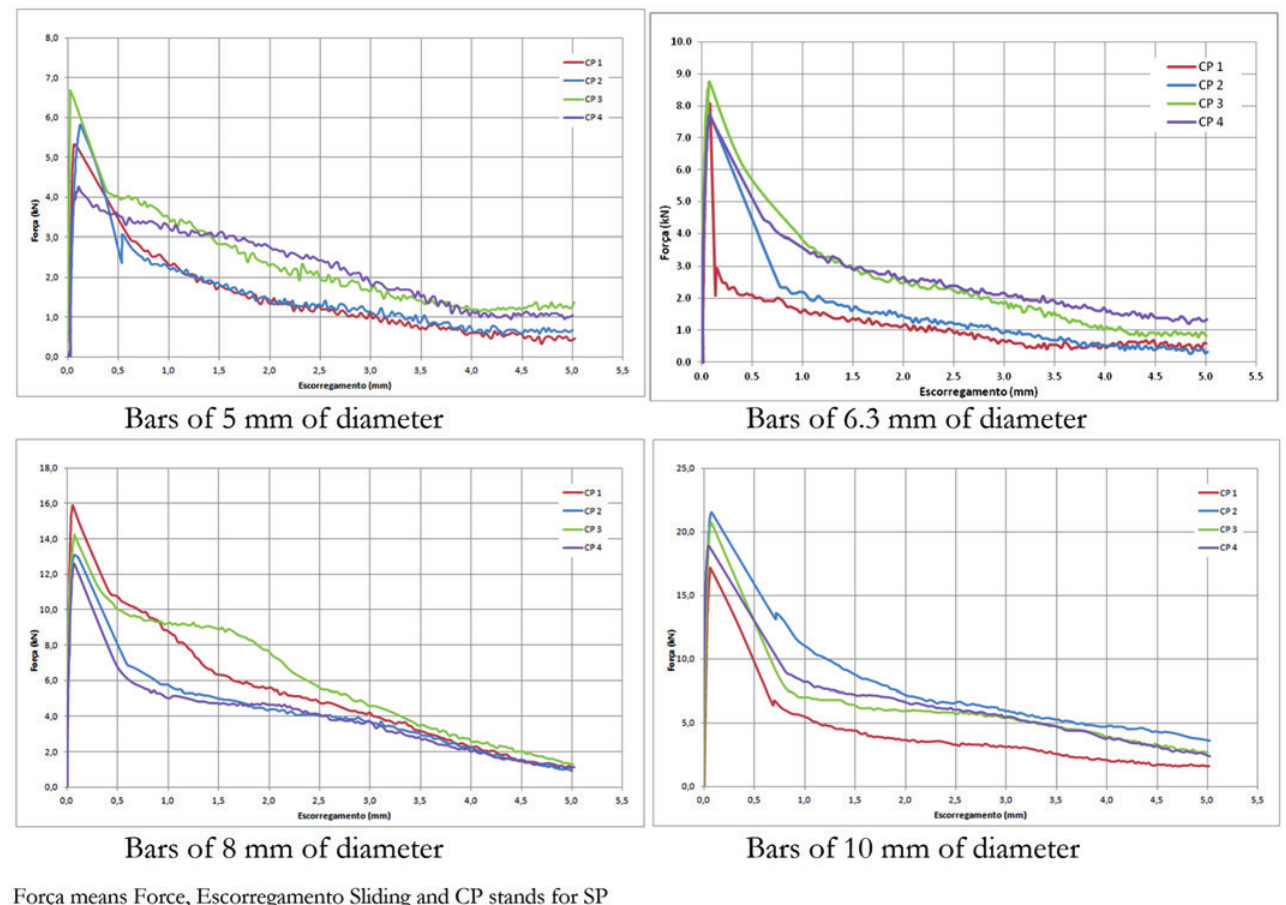
Figure 14 Curves of force versus sliding of the 3 rd batch of